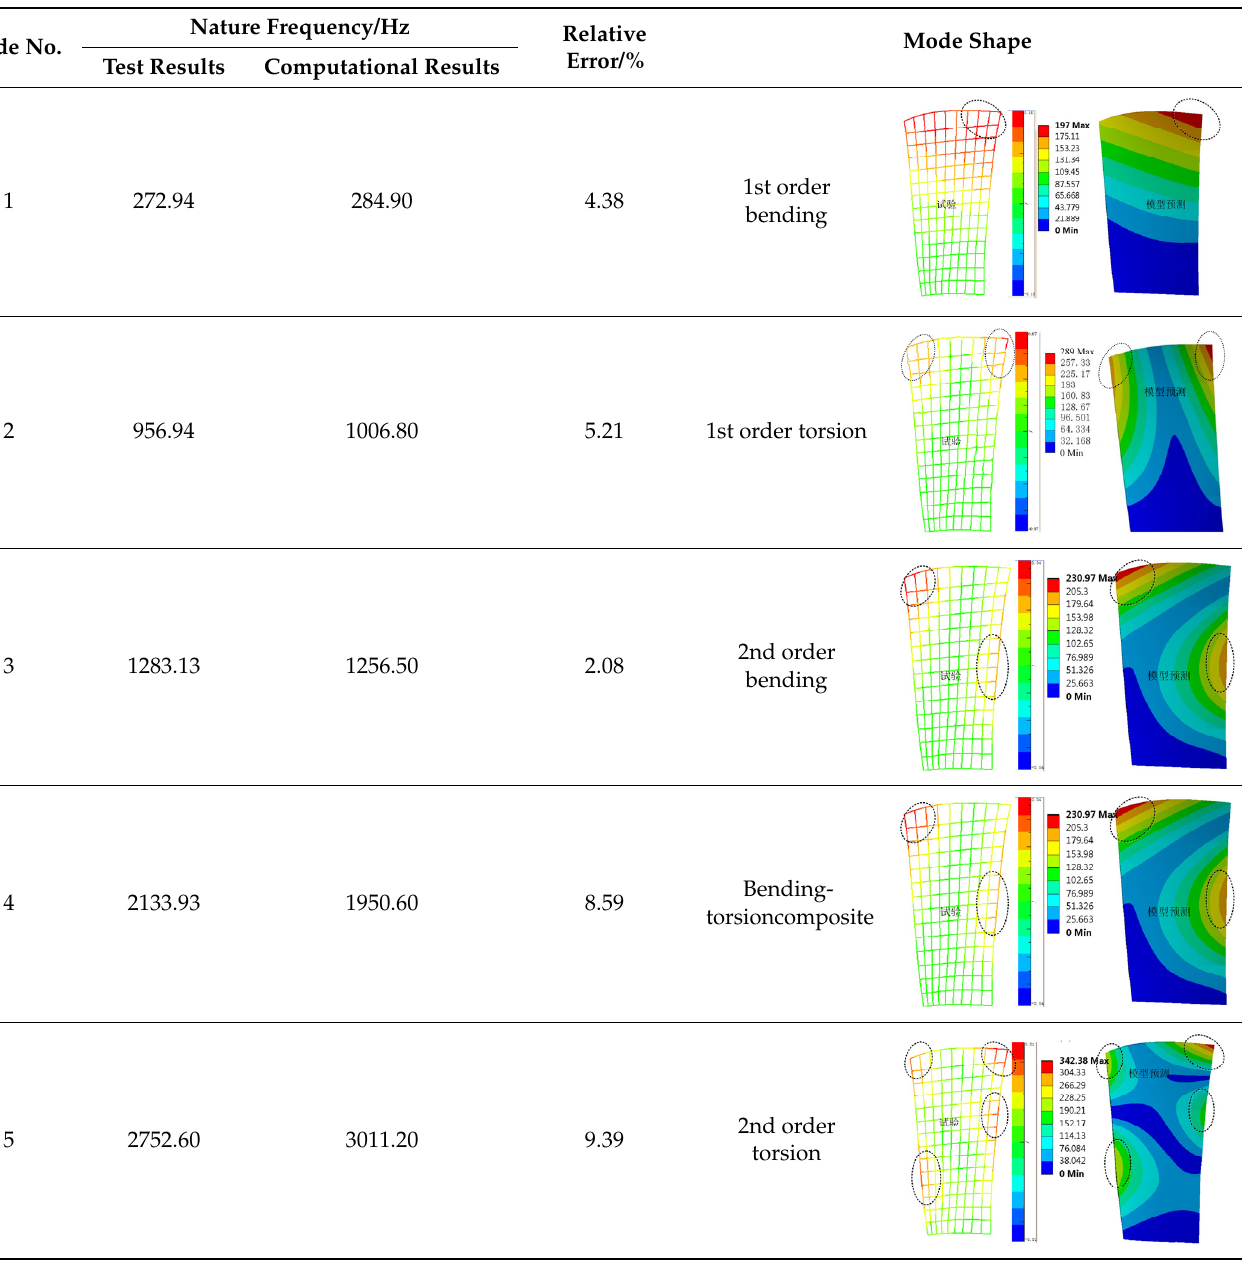
Table 1. Validation results for the finite element model.